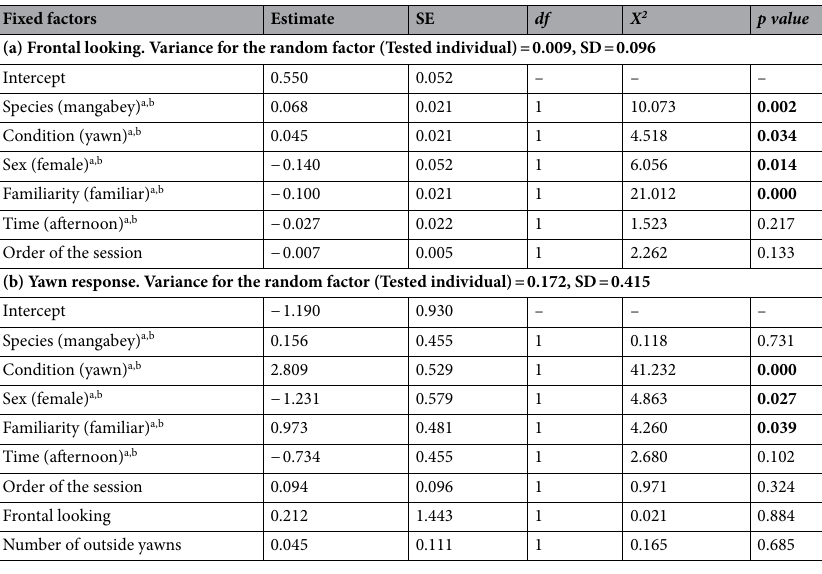
Table 2. (a) Estimated parameters (Estimate), Standard Error (SE), and results of the likelihood ratio tests ( χ 2 ) of the LMM (gaussian distribution) with Frontal Looking as response variable (Model 2a ). (b) Estimated parameters (Estimate), Standard Error (SE), and results of the likelihood ratio tests ( χ 2 ) of the GLMM (binomial error distribution) with Yawn Response as response variable (Model 2c ). For both the models the sessions were 136. Significant values are in bold. a Estimate ± SE refers to the difference of the response between the reported level of this categorical predictor and the reference category of the same predictor. b These predictors were dummy coded, with the “Species (Human)”, “Condition (Control)”, “Sex (Male)”, “Time (Morning)”, “Familiarity (Unfamiliar)” being the reference